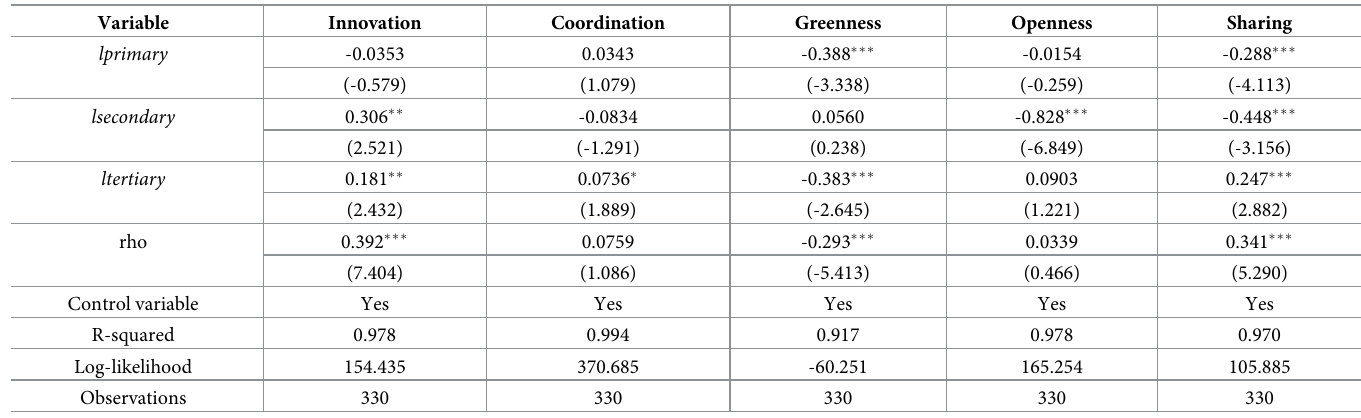
Table 7. SDM estimation results of economic development quality sub-indices.